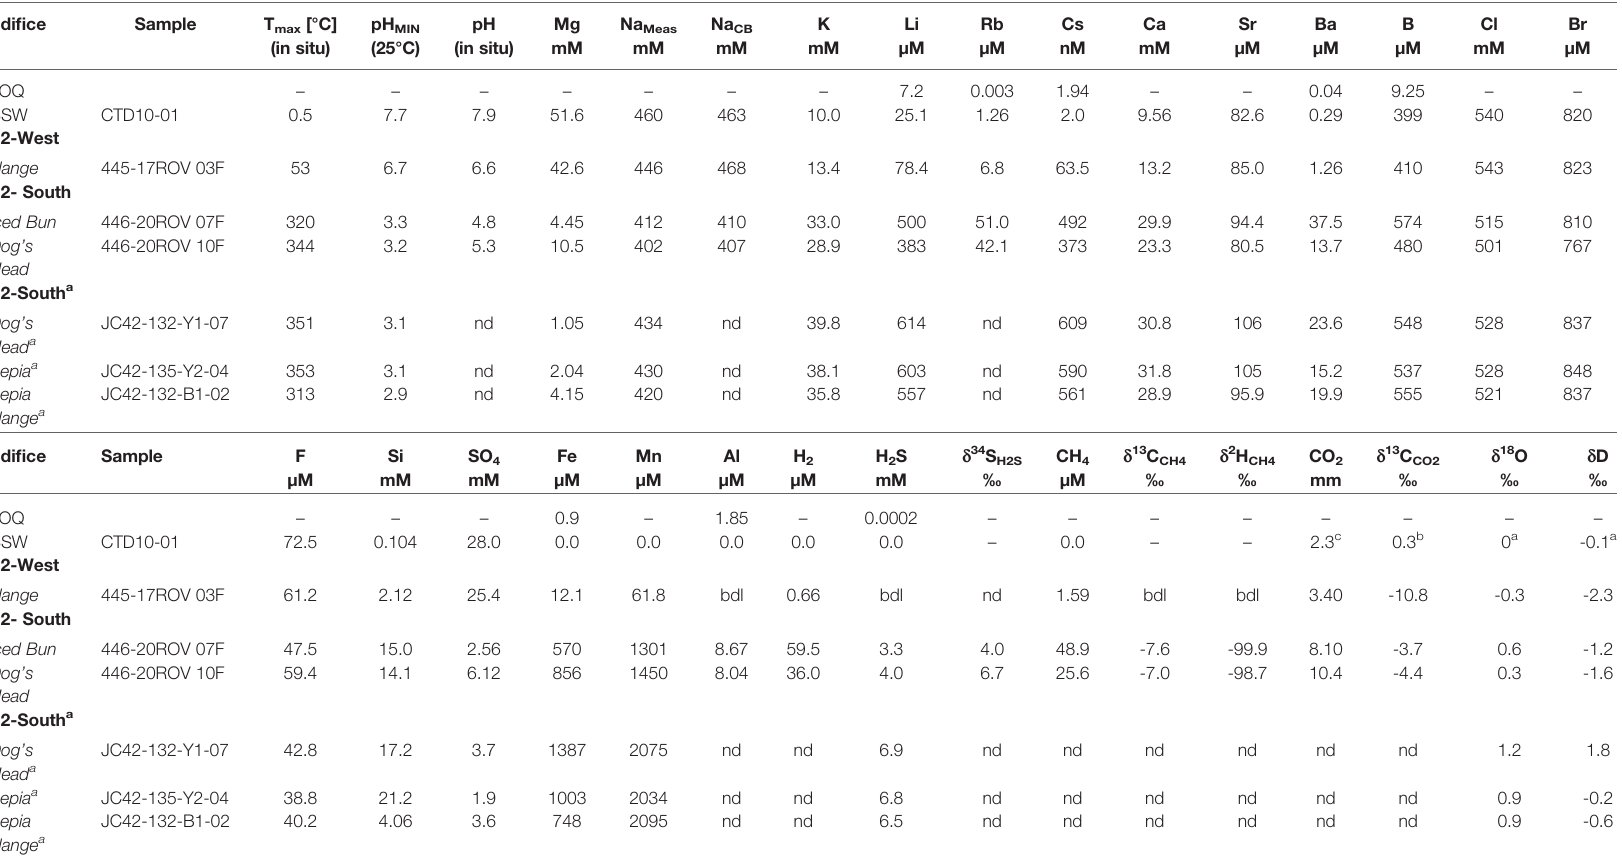
TABLE 1 | Measured concentrations and isotopic composition of aqueous species from the fl uids recovered at E2-South and E2-West hydrothermal vent fi elds. Lowest Mg fl uids sampled in 2010 were added for comparison. Edi fi